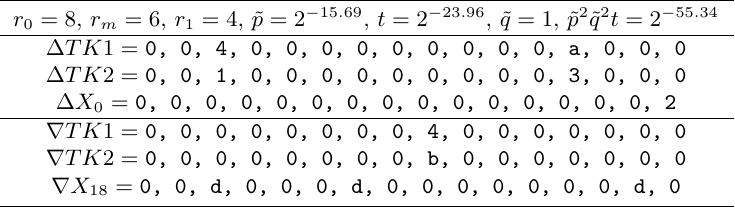
Table 4: The 18-round related-tweakey boomerang distinguisher for SKINNY-64-128 . r 0 = 8, r m = 6, r 1 = 4, ˜ p = 2 − 15 . 69 , t = 2 − 23 . 96 , ˜ q = 1, ˜ p 2 ˜ q 2 t = 2 − 55 . 34